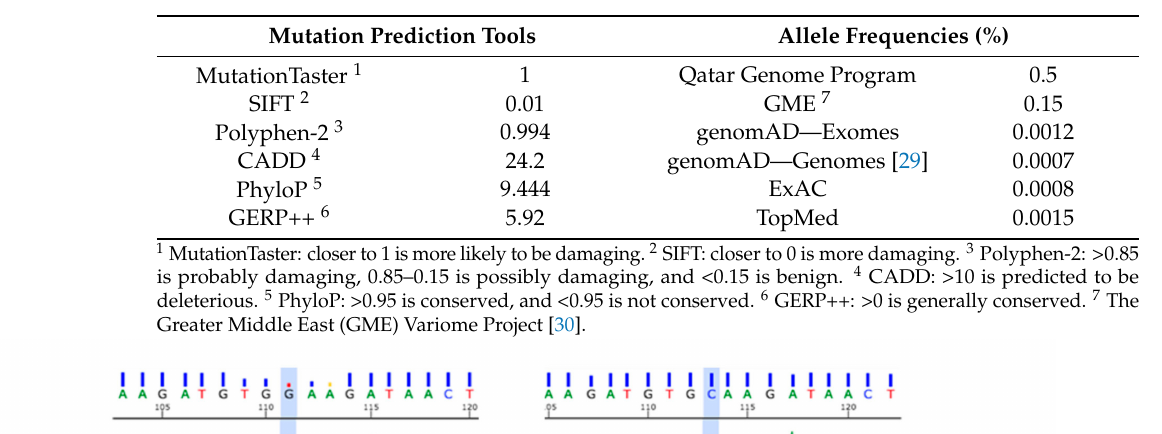
Table 1. Pathogenicity and frequencies of p.E60Q MYO6 variant in the Qatari population.